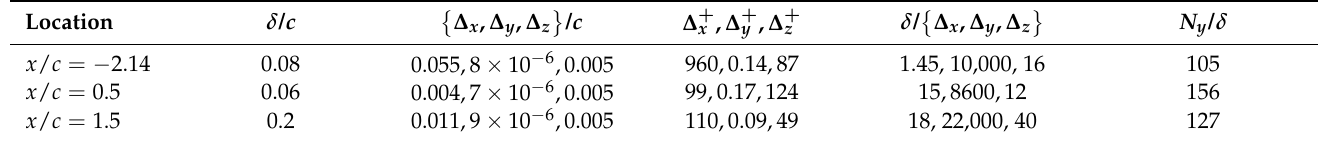
Table 3. Grid scales near the wall-mounted hump for NASA-Mesh system.